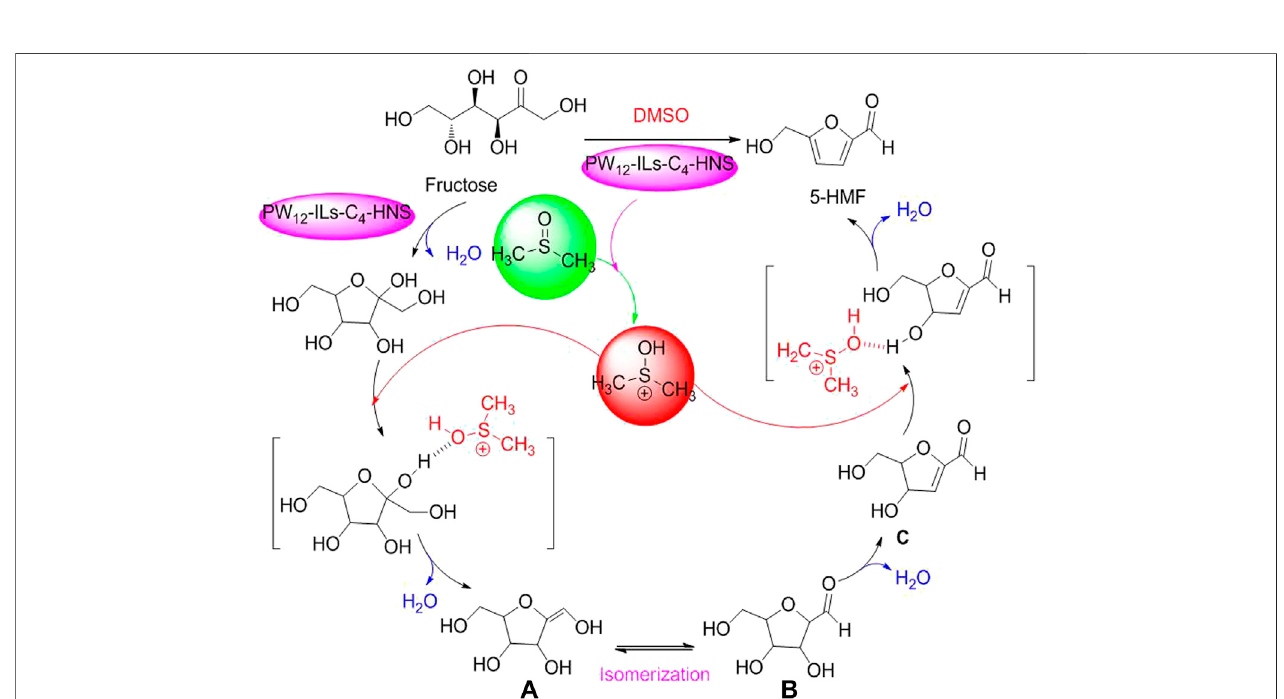
SCHEME 4 | Proposed mechanism for selective conversion of fructose into 5HMF with the assistance of DMSO.